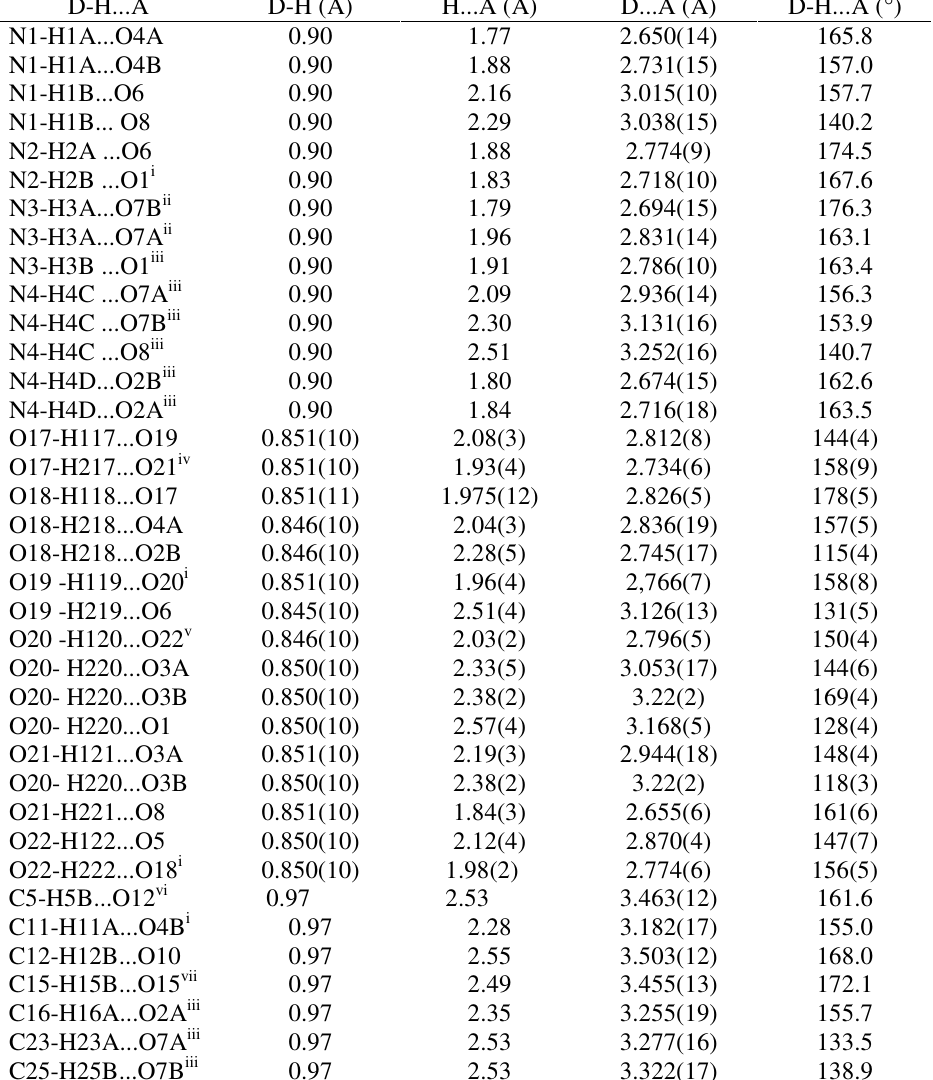
H O NH ) (SO ) .6H 7 12 2 2 4 4 2 2